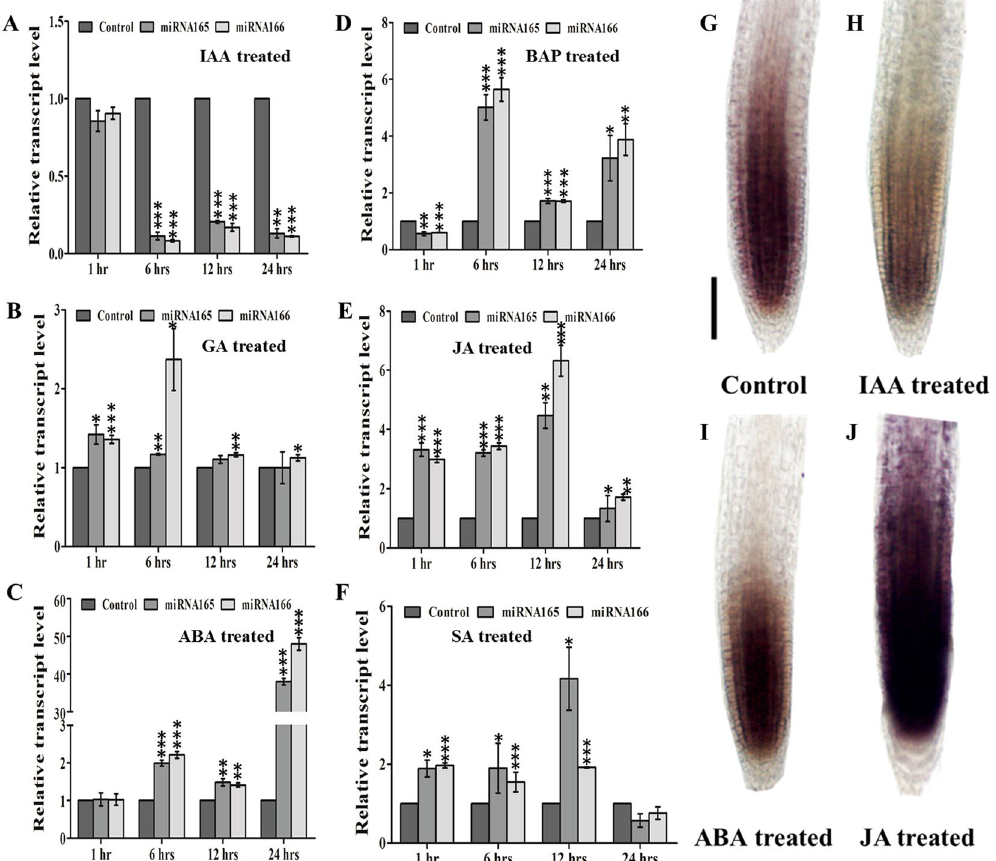
Figure 1. Phytohormones affect the expression level of mature miR166/165. The expression level of miR166/165 was quantified using stem-loop qRT-PCR in roots at 1, 6, 12, and 24 hrs after treatment with ( A ) 10 µ M IAA, ( B ) 10 µ M GA, ( C ) 10 µ M ABA, ( D ) 10 µ M BAP, ( E ) 20 µ M JA, and ( F ) 100 µ M SA. Whole mount in situ localization of miR166/165 was performed in 7 dag roots following 12 hrs of phytohormone treatment ( G–J ). ( G ) Control (without any treatment), ( H ) 10 µ M IAA, ( I ) 10 µ M ABA and with ( J ) 20 µ M JA. In situ localization of miR166/165 in BAP, GA and SA treatment has been provided in Supplemental Fig. S3. Error bars indicate ± SE of two independent biological experiments. One-way ANOVA was performed. Statistically significant differences are indicated as, * for P < 0.05, ** for P < 0.01 and *** for P < 0.001. Scale bar indicates 50 µ